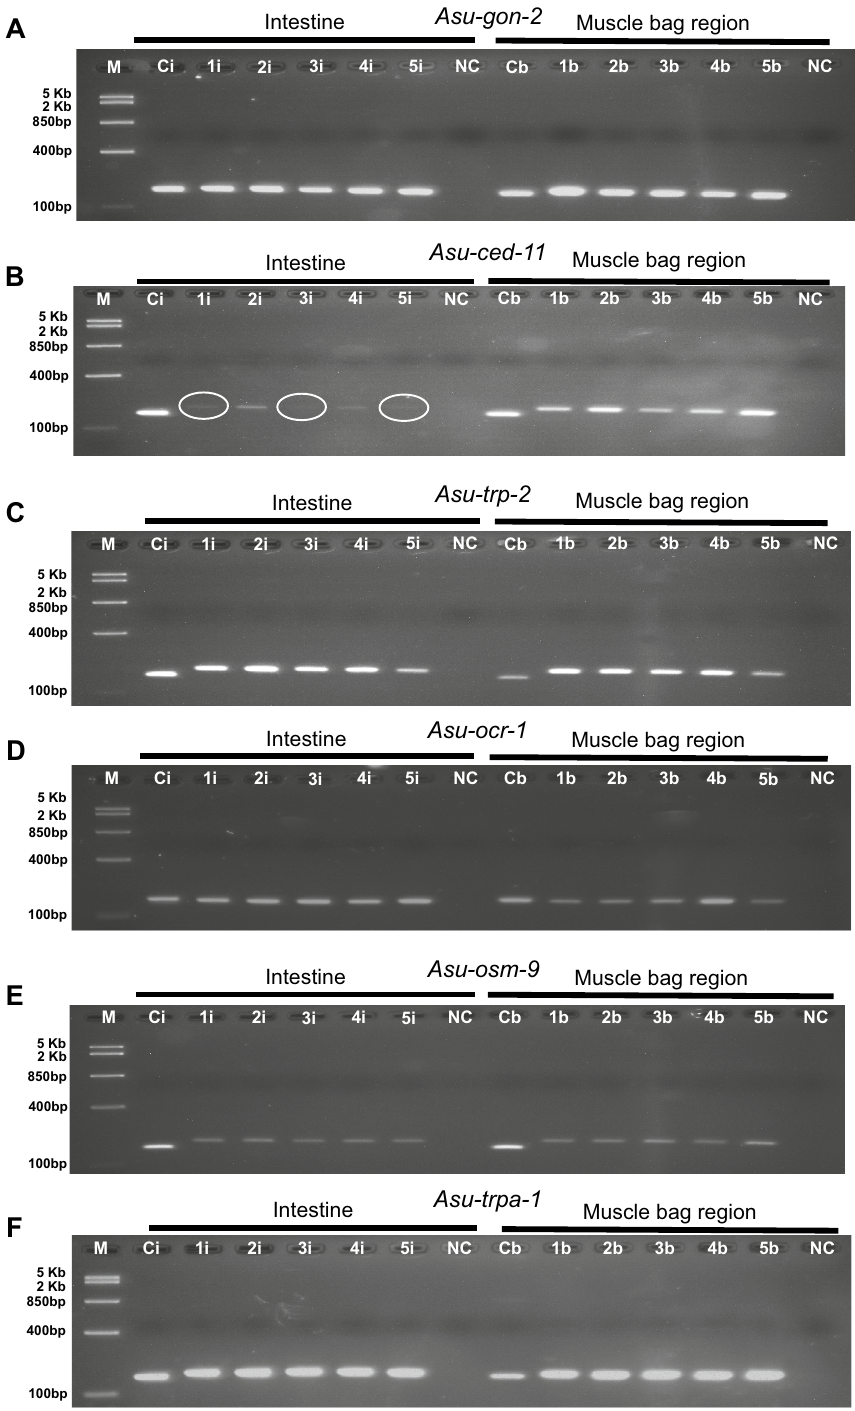
Figure 2. Localization of TRP channels in the intestine and muscle bag region. RT-PCR analysis of intestine (1i, 2i, 3i, 4i, 5i) and muscle bag (1b, 2b, 3b, 4b, 5b) of five separate female A. suum worms. Each lane represents the intestine or muscle bag of an individual worm. Asu-gapdh from the intestine (Ci) or muscle bag (Cb) was used as a positive control. N.C. = negative control, no cDNA template present. M = Fast Ruler Middle Range DNA Ladder (ThermoFisher Scientific). ( A ) Asu-gon-2 , ( B ) Asu-ced-11 ( C ) Asu-trp-2 , ( D ) Asu-ocr-1 ( E ) Asu-osm-9 , ( F ) Asu-trpa-1 . Note the reduced intensity of the bands (white circles) with Asu-ced-11 from the intestine. All images are cropped. Images were taken under UV light with an exposure setting of 3 s per 1 frame. Original gel images are presented in Supplementary Fig.